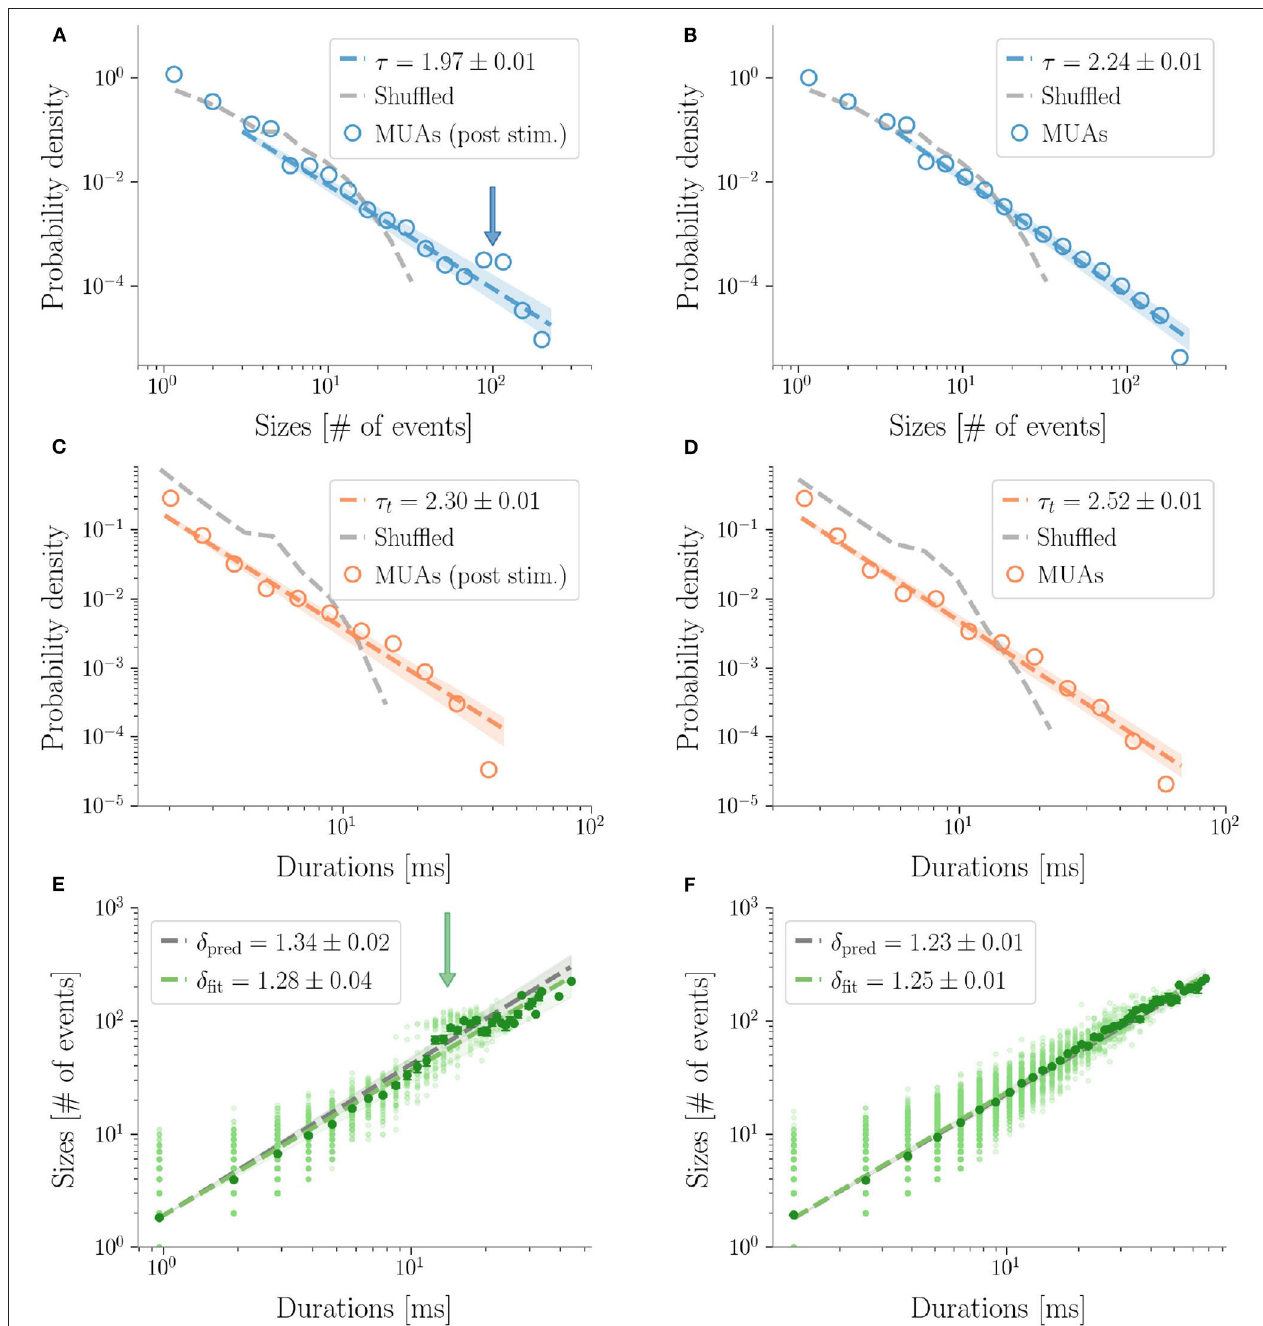
FIGURE 5 | Avalanches in MUAs data. Avalanches sizes probability density in one rat after a stimulus (A) , and during resting state (B) . Notice the bump in the post-stimulus distribution. (C,D) The same, for avalanche durations. Durations are expressed in ms by multiplying the number of bins times h IEI i . In the randomized datasets the exponential distribution provides a better fit in all cases. The shuffling procedure consists in randomizing the occurrence times of the events of each channel, so that the events rate of each channel is preserved. (E,F) The crackling noise relation is verified in both cases within the experimental errors. Once more, notice in (E) the presence of a bump in the post-stimulus